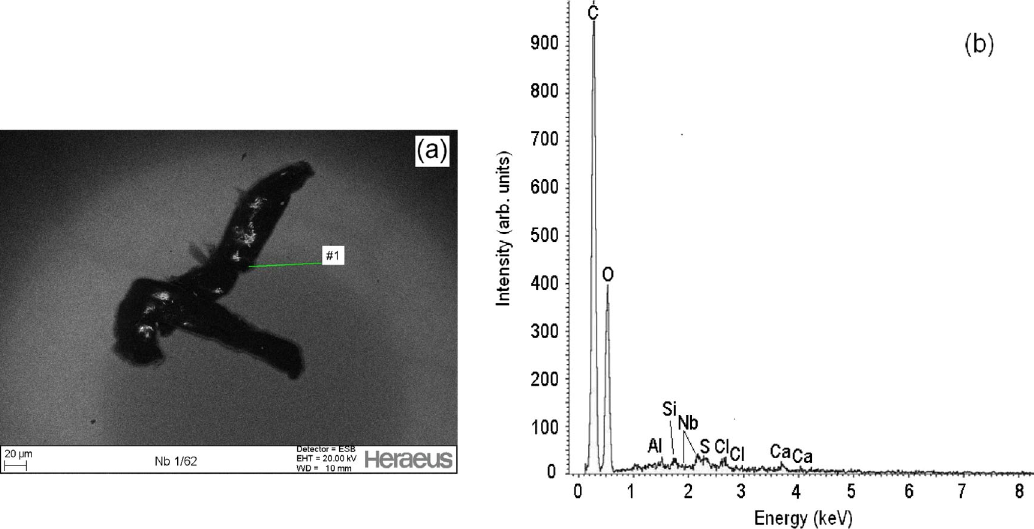
FIG. 5. (a) SEM image of the black spot represented in Fig. 3(b); (b) EDX element analysis of the black spot represented by (a).